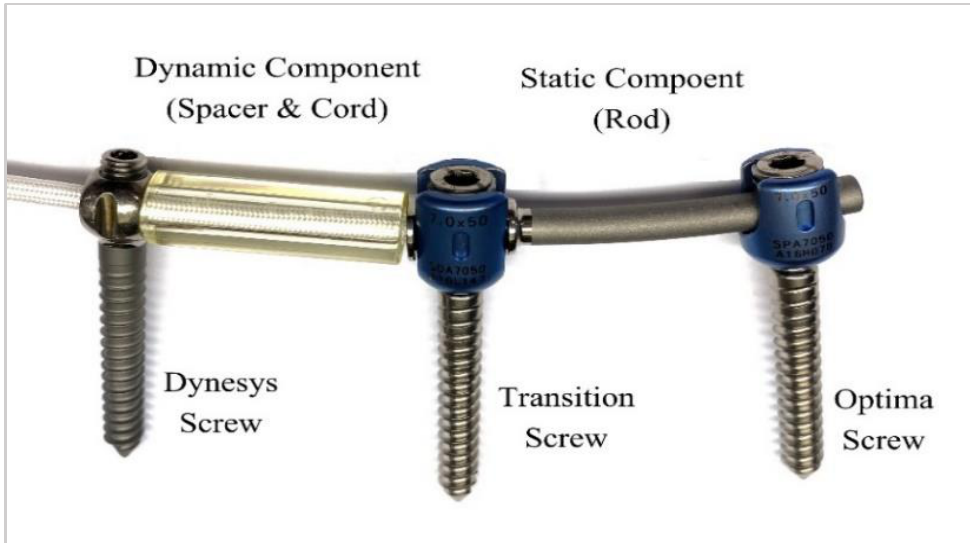
Figure 1. Photograph of the Dynesys-Transition-Optima (DTO) (Zimmer Spine) implant, which is a hybrid (cord–rod) construct comprising a polyester spacer (outer diameter = 11.0 mm and thickness = 2.0 mm) and cord at the dynamically stabilized segment (dynamic component), a titanium rod (diameter = 6 mm) at the rigid fixated segment (static component), and a transition screw connecting the static and dynamic components. The length of the DTO spacer and static components is determined on the basis of the native distance of the pedicles.